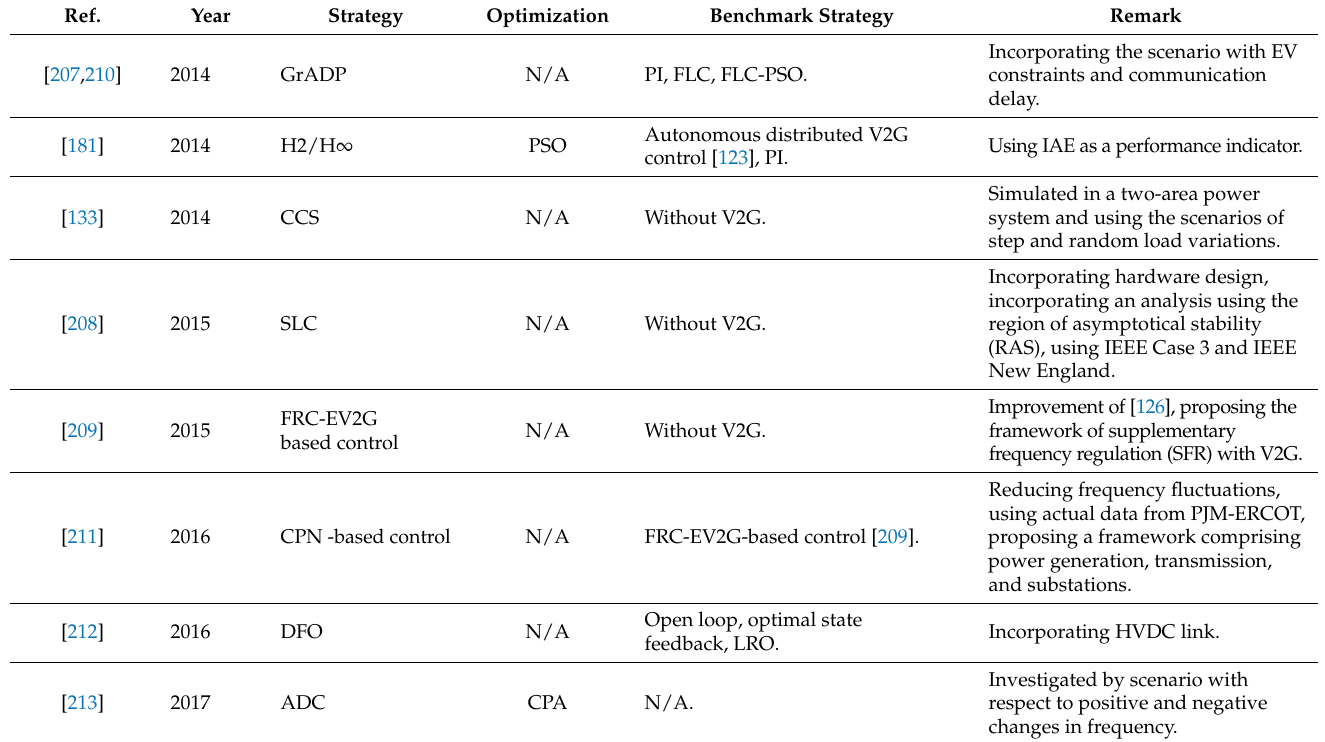
Figure 7. Time order evolution of other variants as EVAS frequency contingency services control method. Table 5. EVAS as a frequency contingency service with other